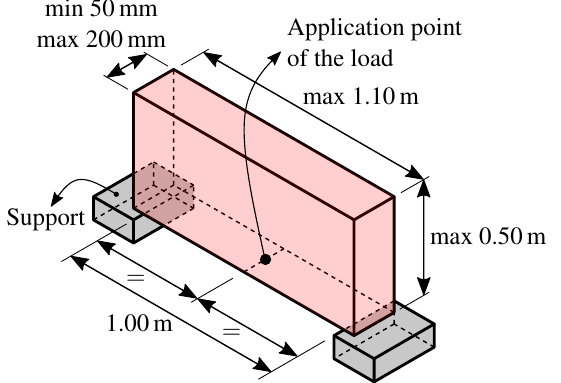
Figure 7. Geometric restrictions for the University of Rio Grande do Sul (UFRGS) Spaghetti Bridge contest (adapted from [42]).